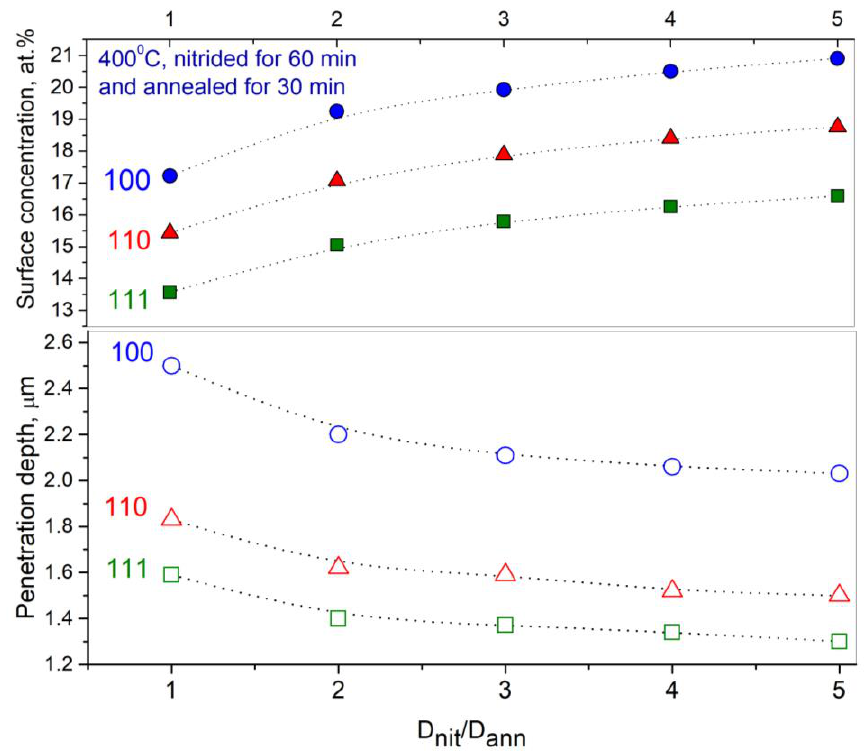
Figure 4. The dependences of nitrogen surface concentration and penetration depth on ratio of D nit /D ann calculated for different crystalline orientations.